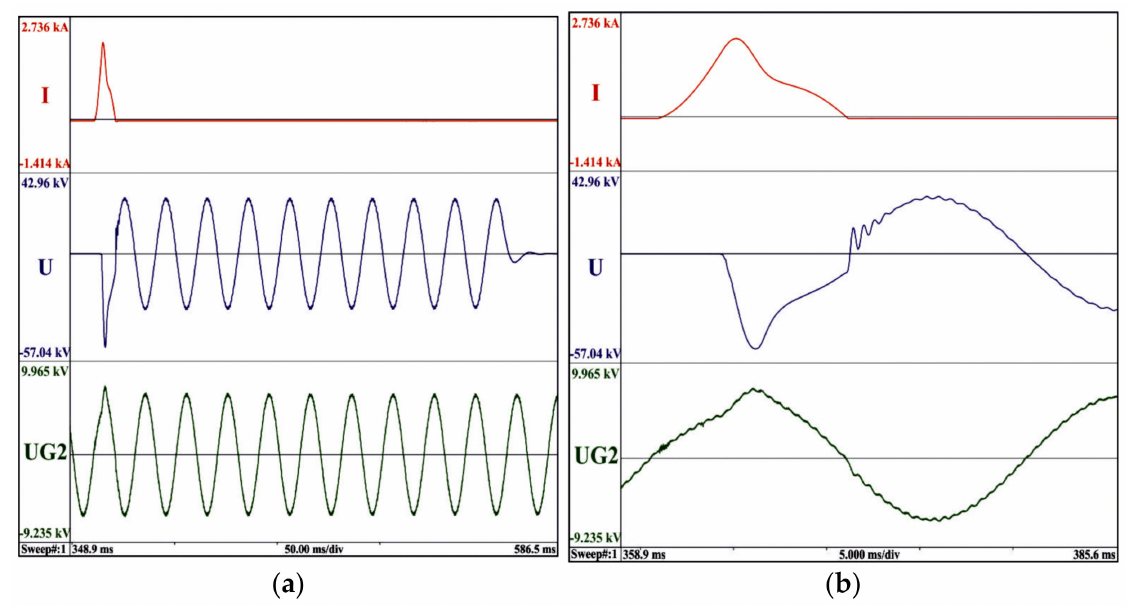
Figure 13. ( a ) Oscillogram obtained for the making angle of short-circuit current of 6.9 electrical degrees; ( b ) connection detail in the